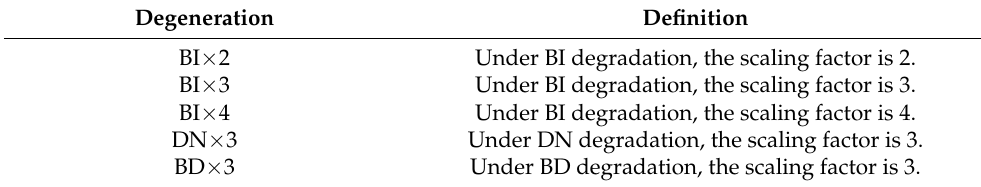
Table 2. Degradation model experiments conducted in this paper. Degeneration Definition BI × 2 Under BI degradation, the scaling factor is 2. BI × 3 Under BI degradation, the scaling factor is 3. BI × 4